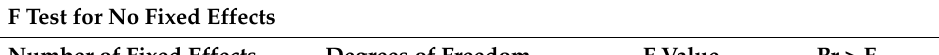
Table 4. Testing the homogeneity hypothesis based on the F test.